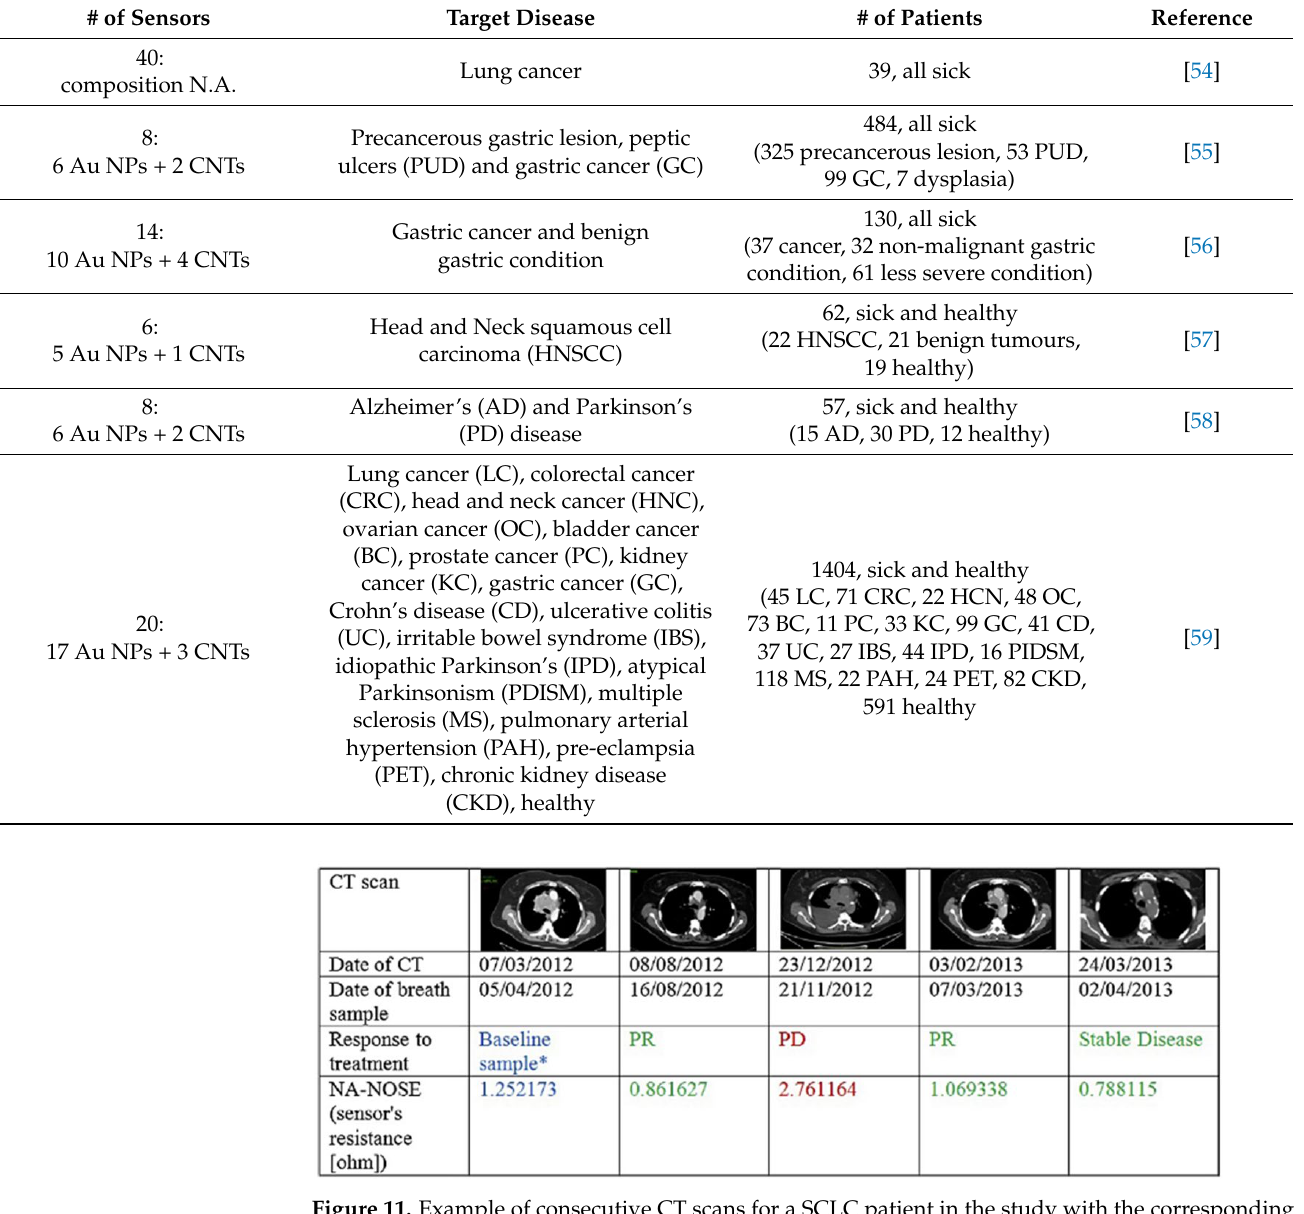
Figure 11. Example of consecutive CT scans for a SCLC patient in the study with the corresponding breath samples and electronic nose (NA-NOSE)’s resistance. * Before initiation of treatment. CT, computerized tomography; SCLC, small cell lung cancer; PD, progressive disease; PR, partial response. Reproduced from [54], copyright (2016), with permission from Elsevier. Gastric diseases, including precancerous gastric lesions, gastric cancer, and benign gastric conditions have been considered by both Amal et al. [55] and Xu et al. [56]. In particular, an early detection of gastric cancer (GC) and the related precancerous lesions by an electronic nose could provide a rapid diagnostic tool to reduce both cancer mortality and incidence. A number of 968 breath samples have been collected from 484 patients with different gastric conditions by [55] and DFA results demonstrate that the nanoarray is able to dis- criminate between GC patients and the control groups (containing patients with peptic ulcer disease (PUD), precancerous lesion and dysplasia) with 73% sensitivity, 98% speci- ficity, and 92% accuracy. Xu et al. [56] proposed the use of an electronic nose as a rapid and alternative tool to upper digestive endoscopy with biopsy and histopathological evaluation of the biopsy material for GC diagnosis. Alveolar exhaled breath from 130 sick patients, i.e., 37 GC pa- tients, 32 patients with ulcers, and 61 with less severe conditions, has been analysed with the DFA method. The results show excellent capability (sensitivity always equal or higher than 84%, specificity equal or higher than 87%) of the e-nose to discriminate between the following subclasses: GC vs. benign gastric conditions, early-stage GC vs. late-stage GC, ulcer vs. less sever conditions. Head and neck squamous cell carcinoma (HNSCC) has been investigated by [57]. Authors assessed that to date, there is not an adequate method for an early detection or screening of the high-risk population of HNSCC. Therefore, the use of an electronic nose can establish the basis for a diagnostic/screening tool for such type of carcinoma. Alveolar exhaled breath samples have been collected from 62 volunteers (22 HNSCC patients, 21 patients with benign tumours, and 19 healthy controls patients). The data ob- tained by the e-nose and analysed with DFA show that the CNTs-based sensors array is able to discriminate between different patients’ subclasses (Figure 12): healthy vs. HNSCC, benign tumour vs. HNSCC, healthy vs. benign tumour, HNSCC larynx vs. HNSCC pharynx, and early vs. late HNSCC. Accuracy is found between 73% and 95%, the sensitivity range is 71–100%, while specificity is between 75% and 91%. The lowest value is always obtained for healthy vs. benign tumour discrimination, while the best per- formances are obtained for discrimination of early vs. late HNSCC. Discrimination between Alzheimer’s (AD) and Parkinson’s (PD) disease and healthy control patients using a CNTs-based e-nose is reported by Tisch et al. [58].